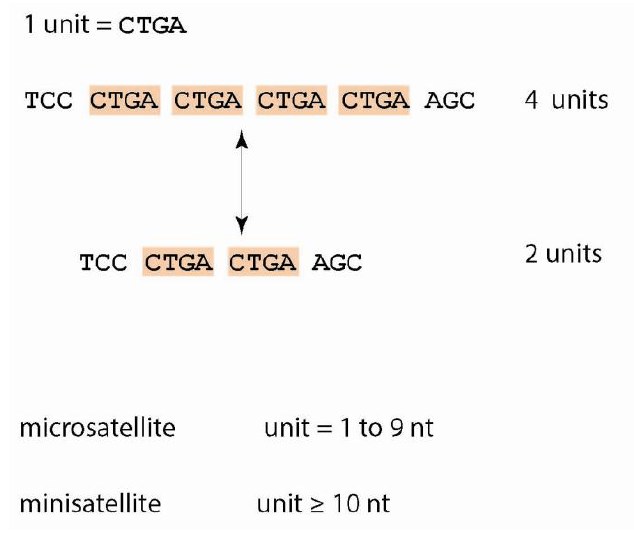
Figure 1. Main definitions and characteristics of tandem repeats (TRs). TRs are unstable due to frequent changes in the number of repeat units. TRs with short unit length are also called microsatellites and those with long units are called